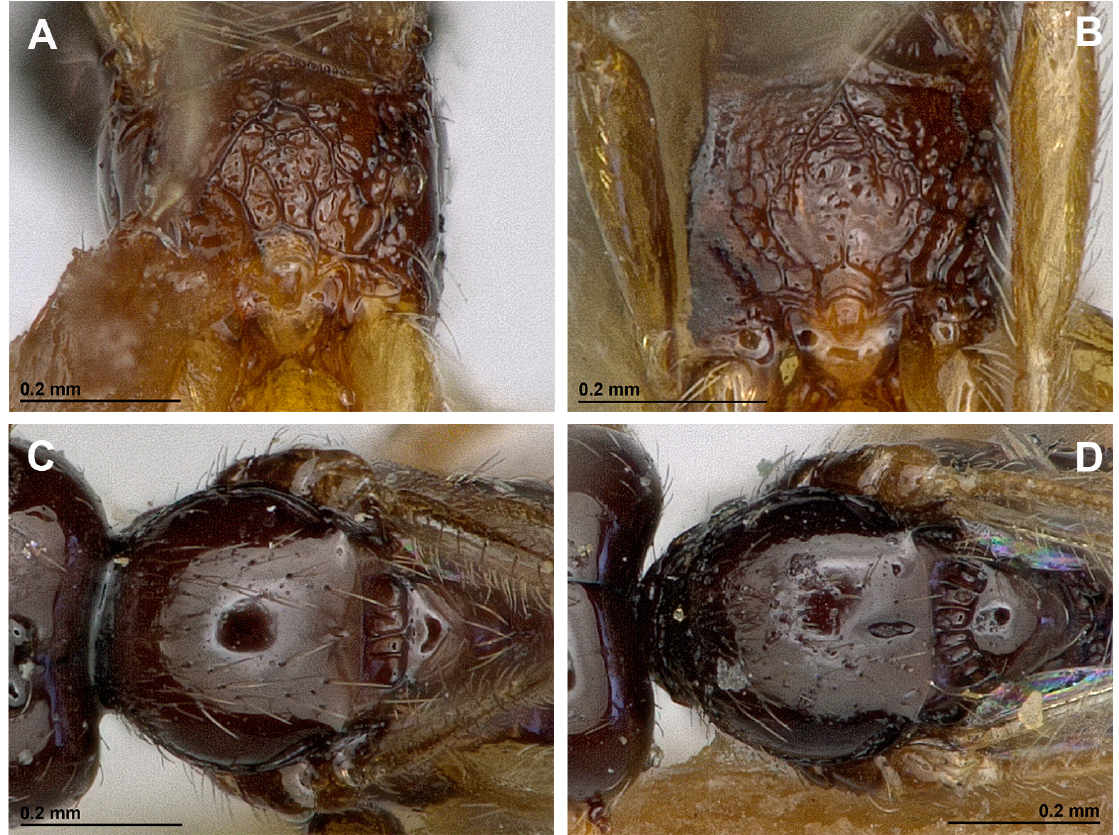
Fig. 15. A . Propodeum of Synaldis altera Fischer, 1967, dorsal view. B . Propodeum of S. difficilis Fischer, 1967, dorsal view. C . Mesonotum of S. difficilis Fischer, 1967, dorsal view. D . Mesonotum of S. numerosa Fischer, 1967,